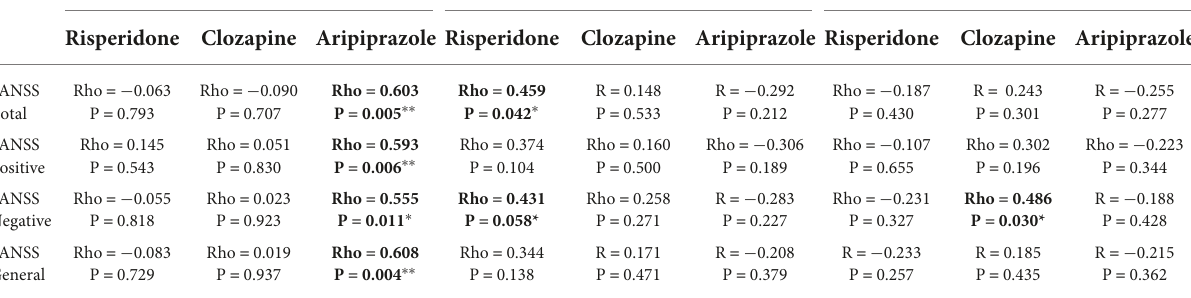
TABLE 3 Correlation of PANSS and measured cytokines in each treated group. TNF- α IL-33 TGF-